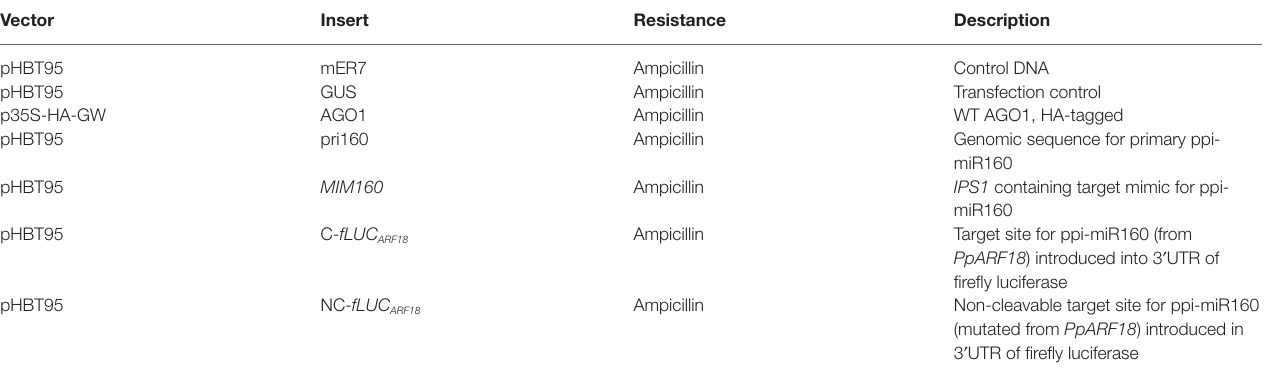
TABLE 1 | List of the plasmids used in protoplast transfection. Vector